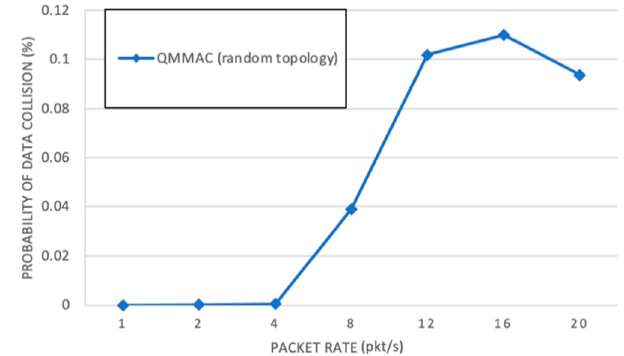
Figure 21. Data collision probability.